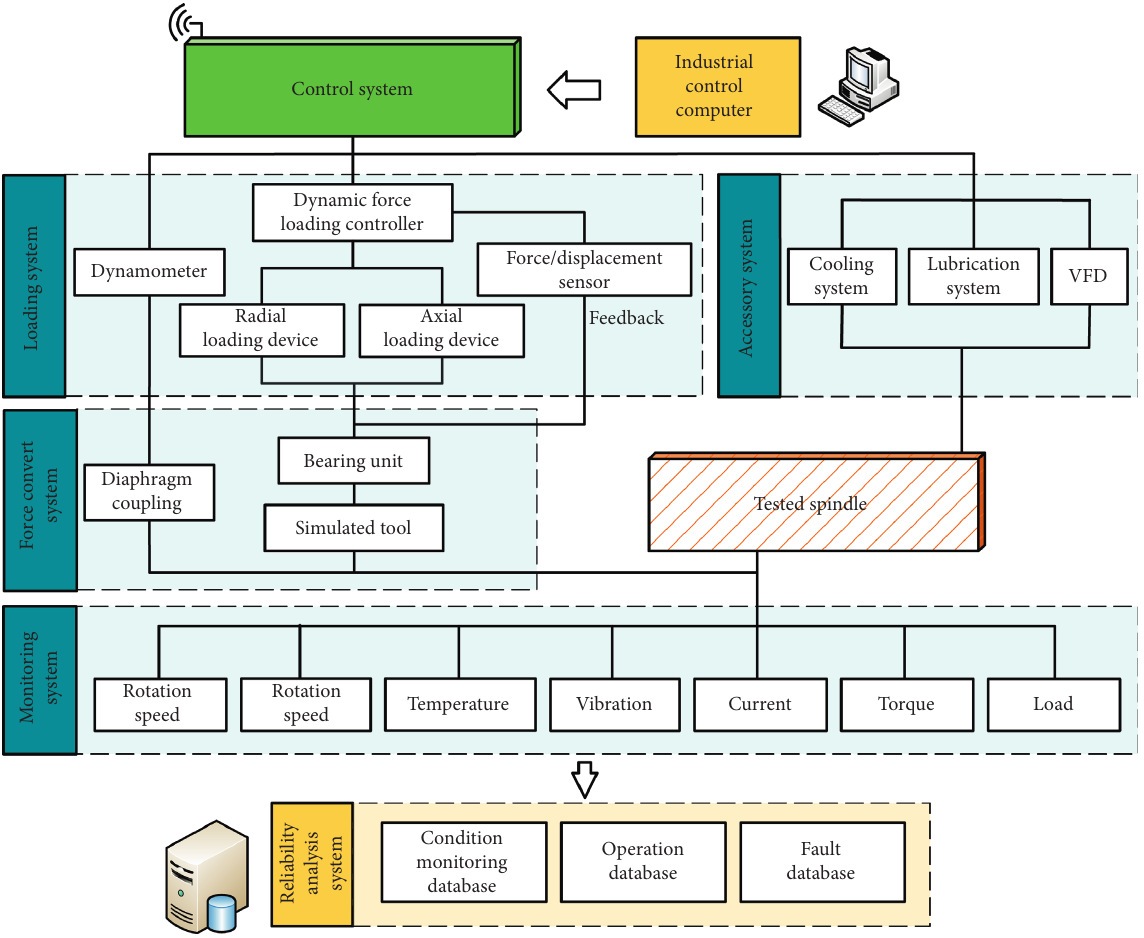
Figure 5: The control strategy of the RTR.